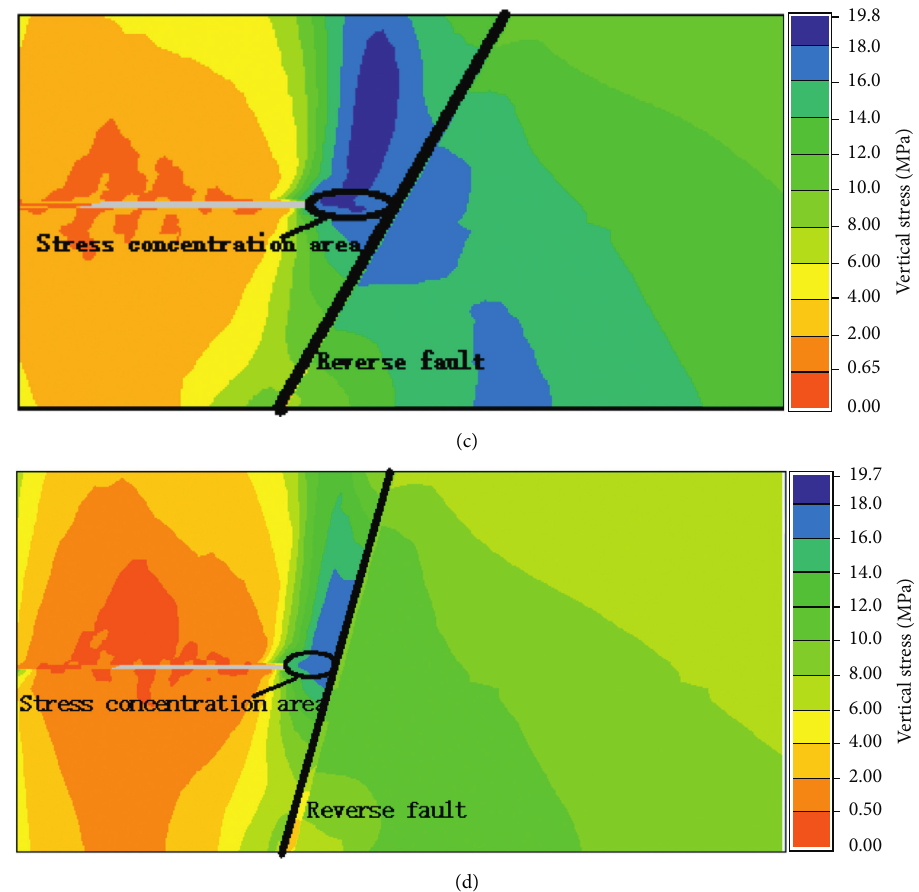
Figure 10: Stress distribution when the distance between working face and reverse fault is 10m with different dip angles. (a) The dip angle of reverse fault is 30 ° . (b) The dip angle of reverse fault is 45 ° . (c) The dip angle of reverse fault is 60 ° . (d) The dip angle of reverse fault is 75 °